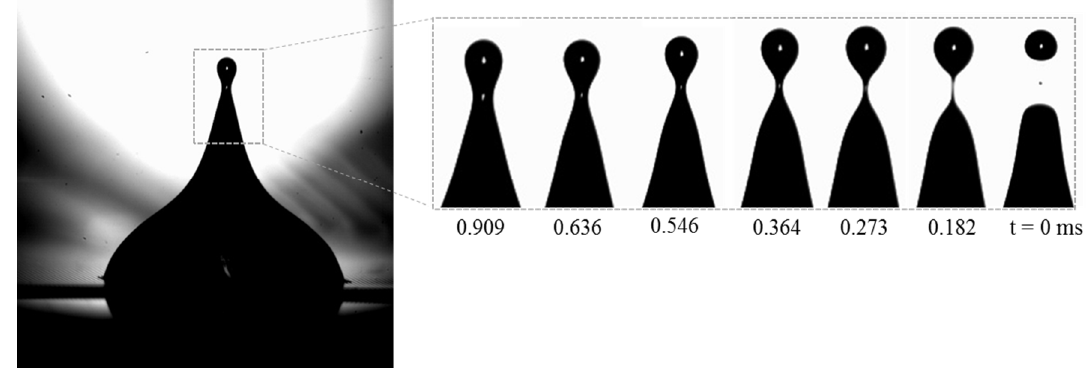
Figure 6. A more detailed image of the necking and jet breakup over time for 50% G solution ( Oh = 0.017, U i = 0.7004 m/s, We = 22.6, Re = 280.2). For scaling of the necking diameter, t = 0 when the satellite droplet breaks away from the jet tip.